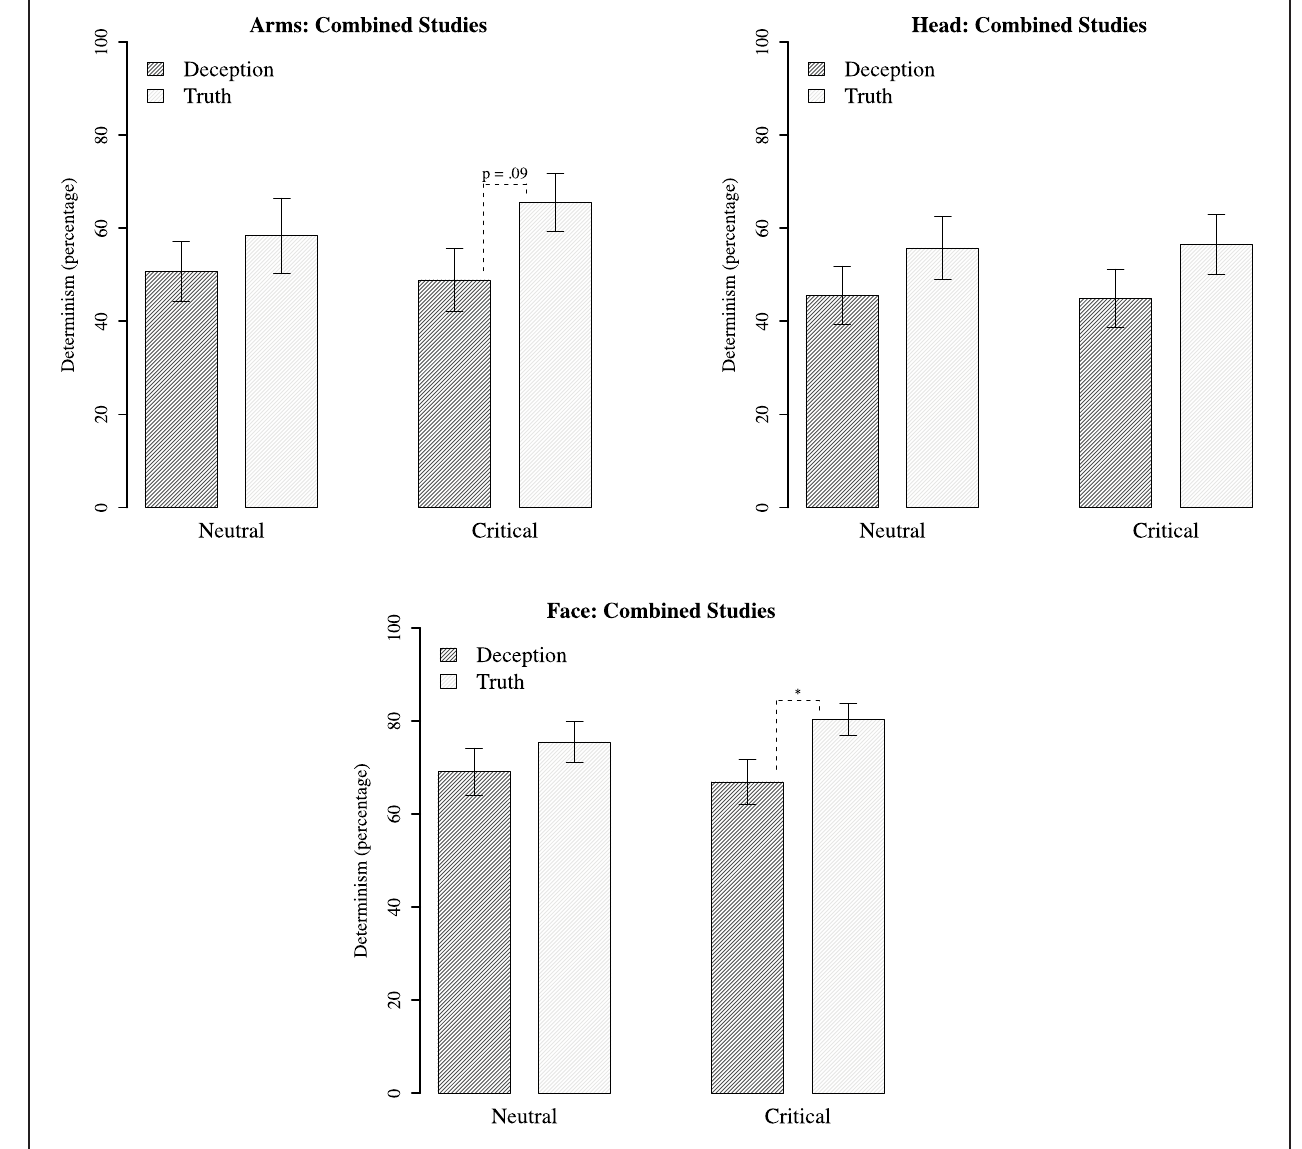
FIGURE 8 | Mean percentage of determinism for RQA. Standard error plotted for each bar. ∗ p < 0.05.